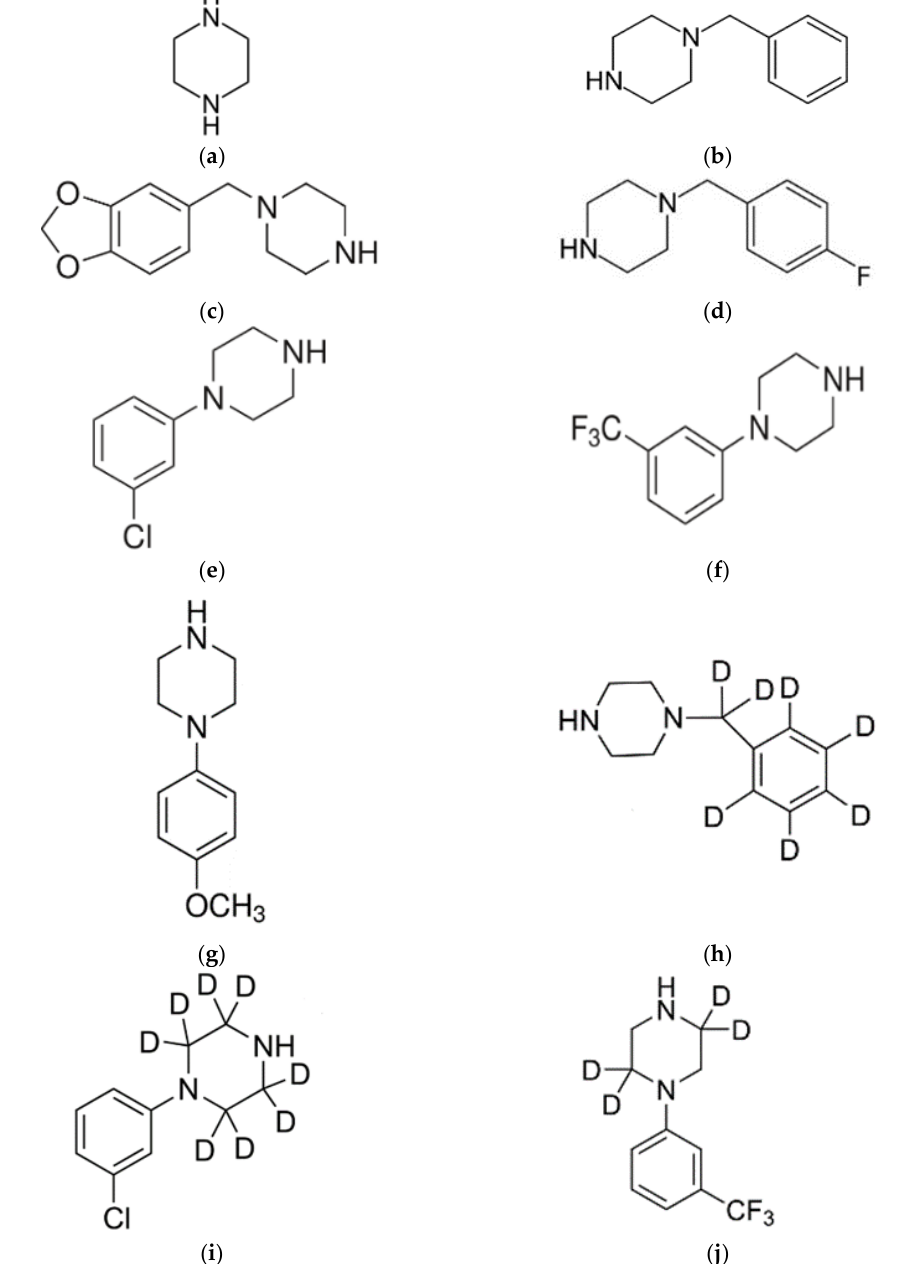
Figure 1. Chemical structures of ( a ) piperazine, piperazine derivatives: ( b ) N -benzylpiperazine (BZP), ( c ) 1-(3,4-methylenedioxybenzyl)piperazine (MDBP), ( d ) 1-(4-fluorobenzyl)piperazine (pFBP), ( e ) 1-(3-chlorophenyl)piperazine (mCPP), ( f ) 1-(3-trifluoromethylphenyl)piperazine (TFMPP), ( g ) 1-(4-methoxyphenyl)piperazine (MeOPP) and deuterated internal standards ( h ) BZP-D7, ( i ) mCPP-D8, ( j ) TFMPP-D4. BZP doses taken by consumers range from 50 to 250 mg and even up to 1000 mg [7,14,15], with the possibility of detection in the blood up to 30 h after ingestion [16]. TFMPP doses have been reported in the range of 5 to 100 mg [5,15,17]. The effect is not immediate, but it lasts from 6 to 8 h [5]. In turn, in the combination of BZP and TFMPP, the following proportions were recorded: 100 mg BZP and 30 mg or 50 mg TFMPP and 80 mg